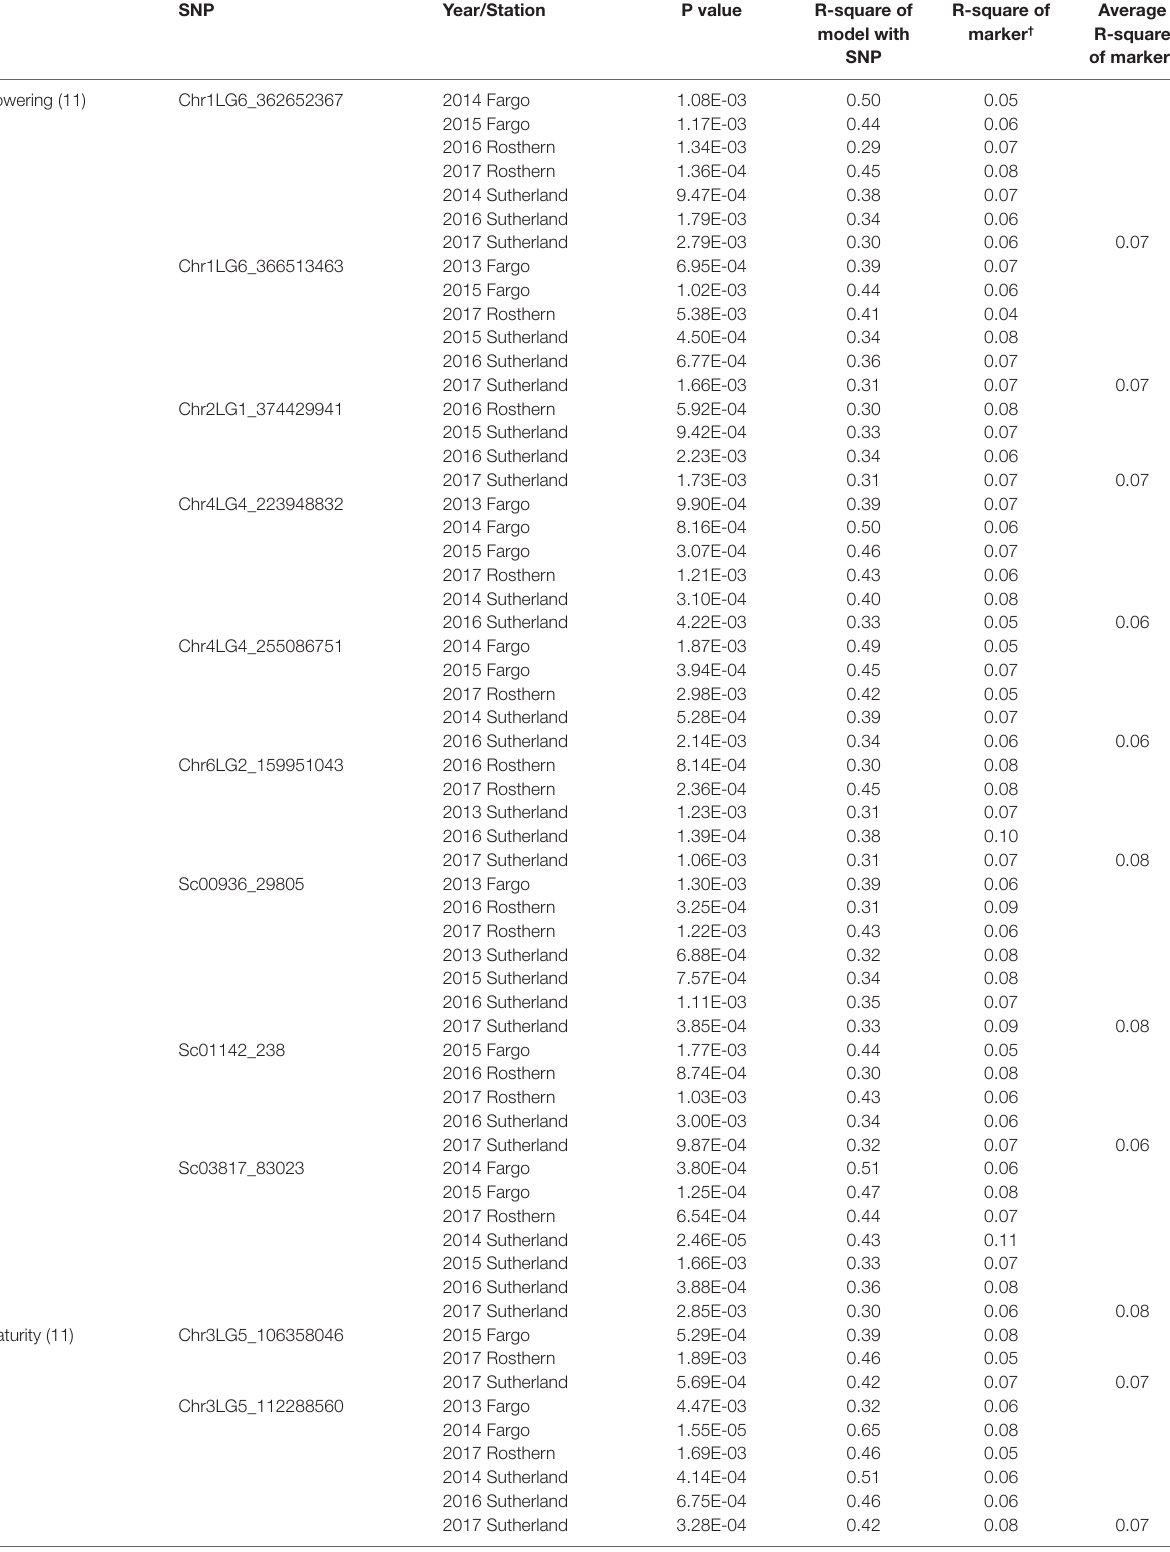
r-square of Average model with marker † r-square SnP of marker †